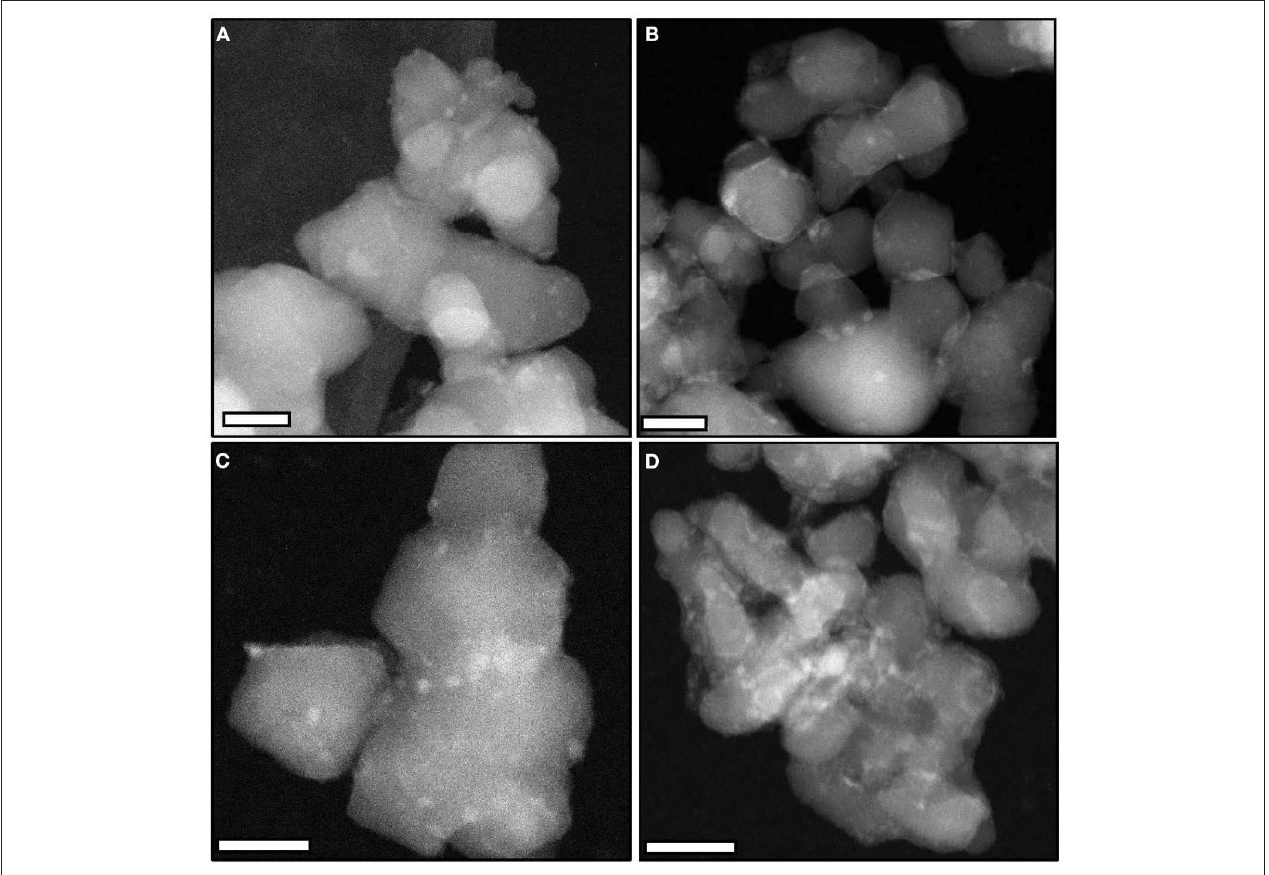
FIGURE 2 | Representative STEM-HAADF images (scale bars, 20nm) of (A) MoC/TiO 2 - P, (B) MoC 10E − 700 /TiO 2 - P, (C) MoC 10M − 700 /TiO 2 - P, and (D) MoC 20E − 700 /TiO 2 -D.